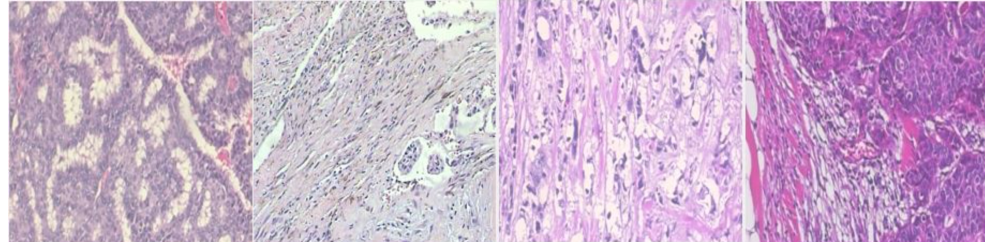
Figure 13. Example images after applying oversampling data augmentation